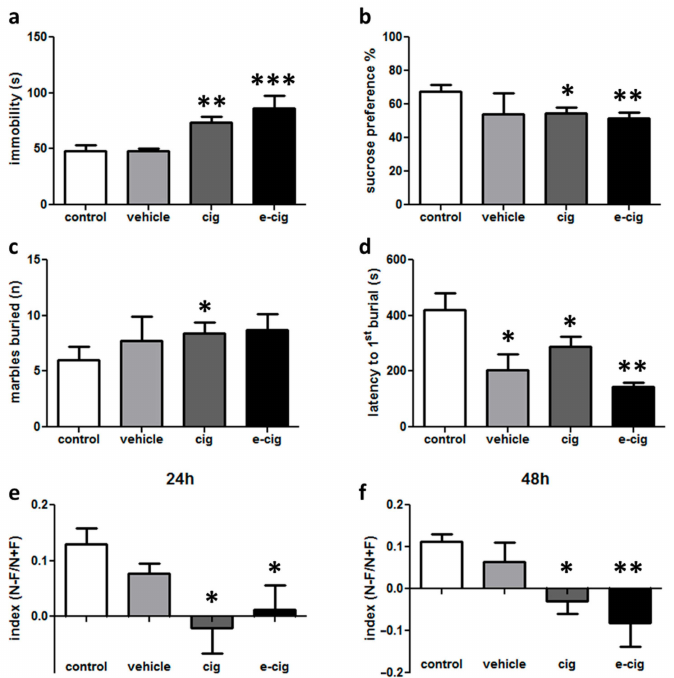
Figure 1. Depressive-like behaviour evaluated in the cigarette (cig), e-cigarette (e-cig) and vehicle mice compared to the control group at 60 days of withdrawal: ( a ) immobility time evaluated for 6 min in the tail suspension test; ( b ) sucrose preference measured in terms of the percentage of the consumed sucrose solution to the total volume of liquid consumed. The evaluation of anxiety-like behaviour in the marble burying task as the total number of buried marbles ( c ) and latency to the first burial ( d ) evaluated within 15 min. Cognitive impairments evaluated in the spatial object recognition test as the discrimination index at a 24 h ( e ) or 48 h delay ( f ). n = 4–32 for each group. *** p < 0.001; ** p < 0.01, * p < 0.05 in the Planned Comparison vs.